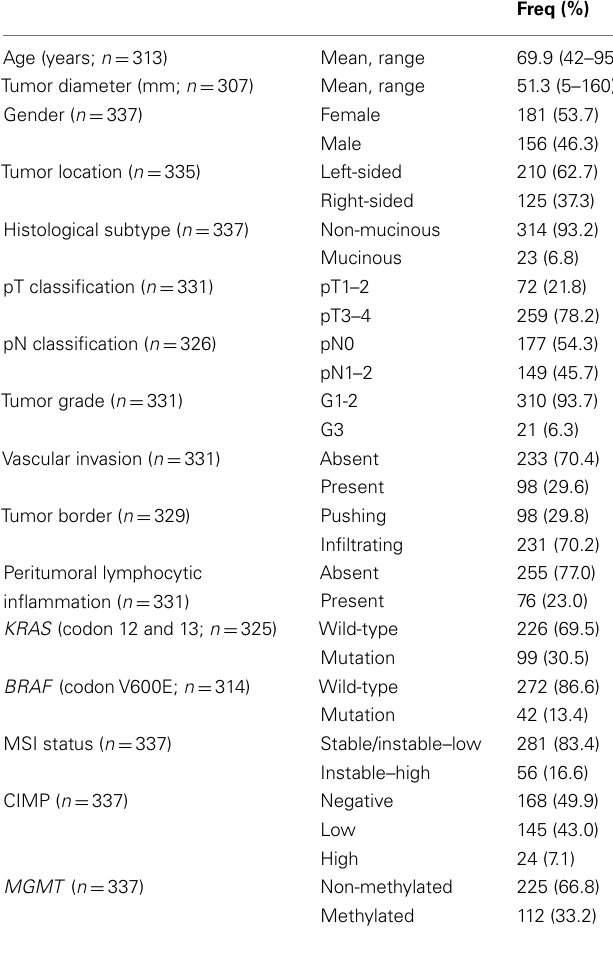
Table 1 | Patient characteristics ( n =